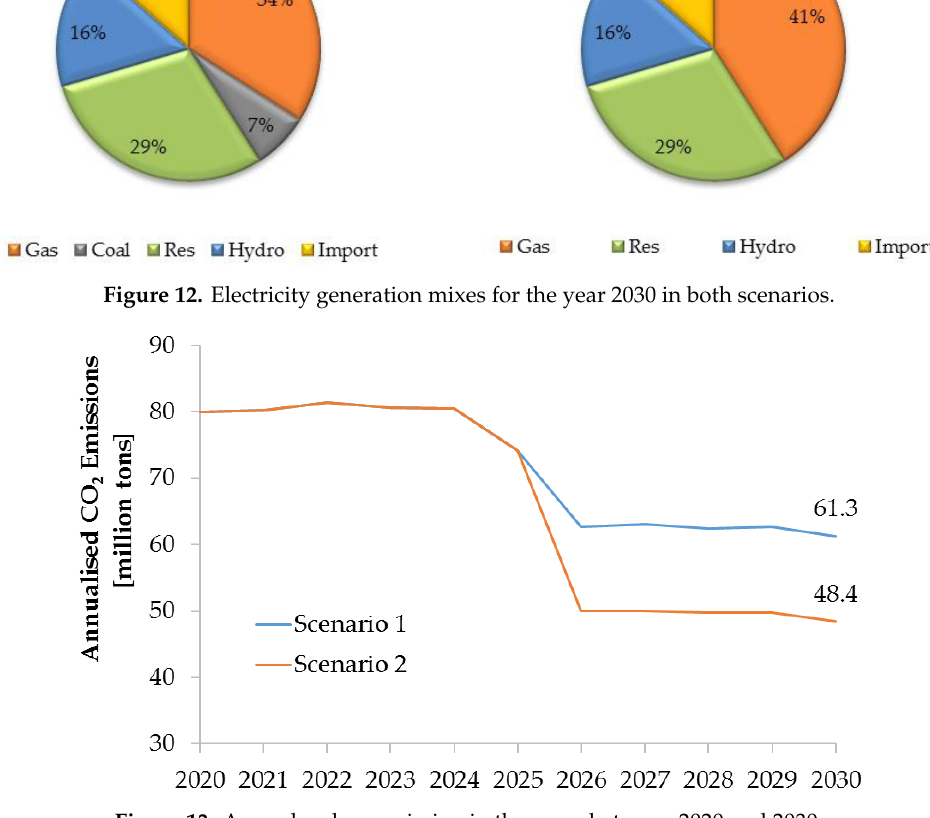
Figure 13. Annual carbon emission in the years between 2020 and 2030.